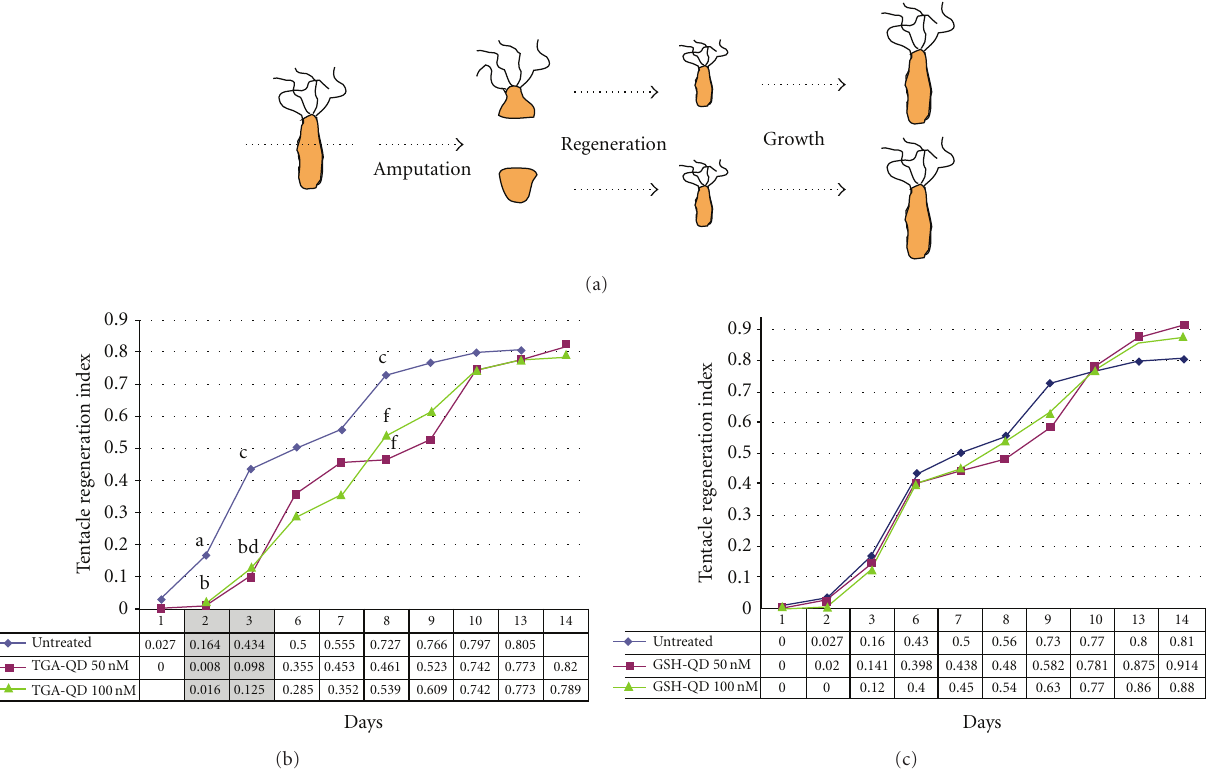
Figure 4: Mean tentacle regeneration indices (TRI) plotted against corresponding days of regeneration. In (a), a scheme of the regeneration is illustrated. Groups of 4 Hydra treated with TGA-QD (b) or GSH-QD (c) were bisected and allowed to regenerate for 14 days. For each type of QD, two di ff erent concentrations were tested (50nM, purple line, and 100nM, green line) and compared to untreated regenerating Hydra . Mean TRI values with diverse letter are significantly di ff erent (unpaired t -test ( P < .